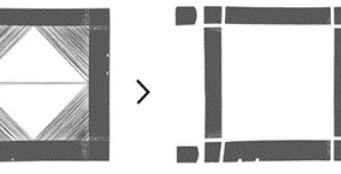
Figure 10. Processed Delaunay mesh of ceilings.